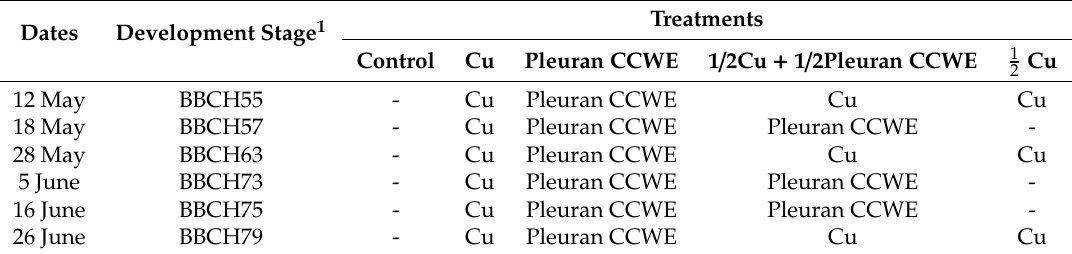
Table 4. Calendar of vine treatments during field trial. -: no treatment.